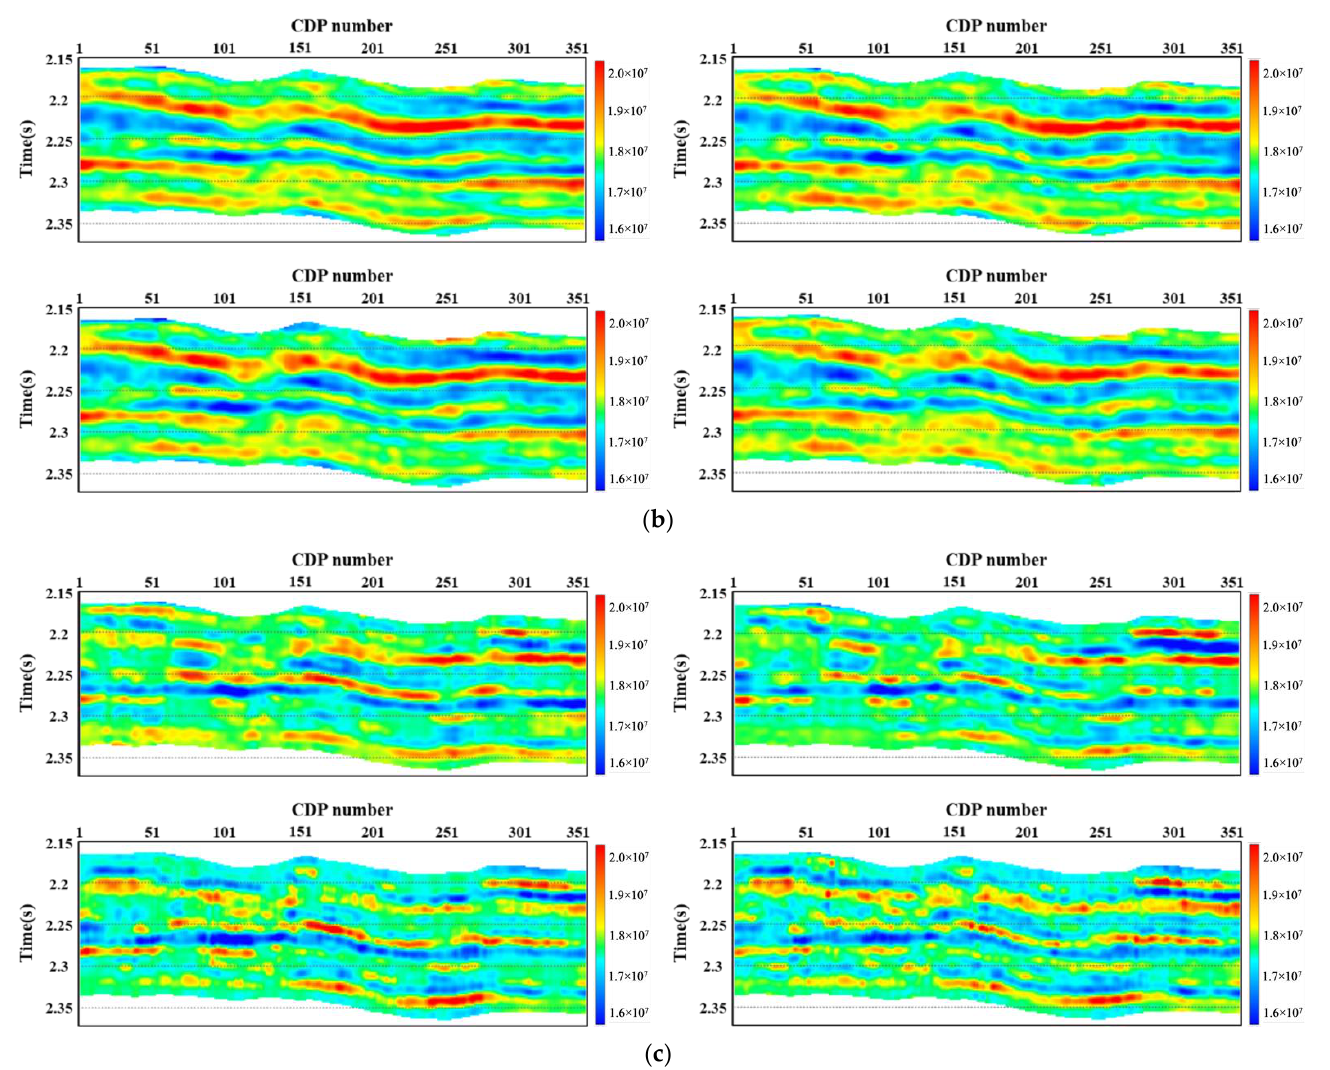
Figure 8. Estimated azimuthal EI datasets, where ( a ) small angle, ( b ) middle angle, and ( c ) large angle.